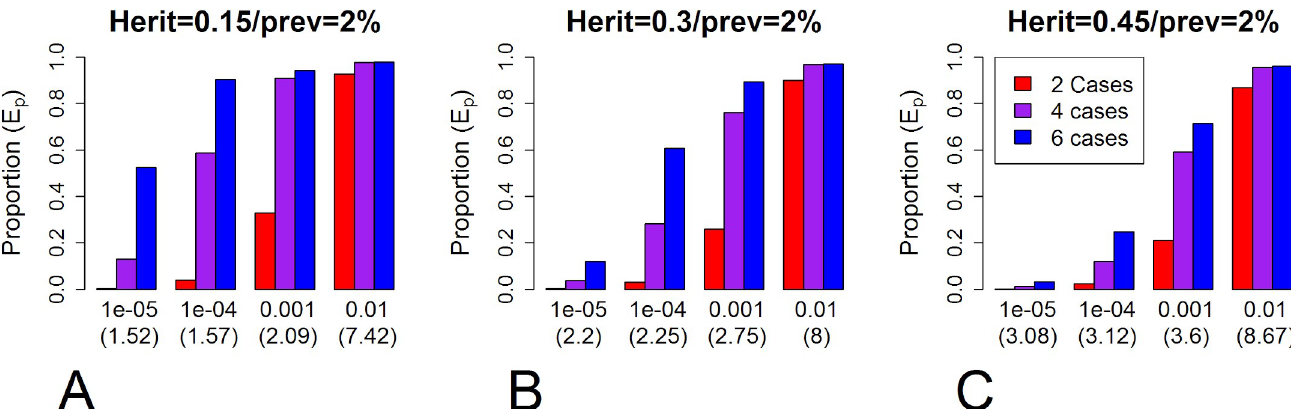
Fig 2. Proportion carrying HPRV in affected sibships. The proportion ( E a disease with a 2% prevalence (100 × π � ) in the population. Panels A, B, and C represent different values of polygenic heritability (A: s 2 s 2 ¼ 0 : 45 ). Within a panel, the four sets of bars represent different MAF ( p P Sibling Relative Risk). Within a set of bars, the colors represent the different number of children (red: n T Supporting Information: S2 Fig for diseases with other prevalences.